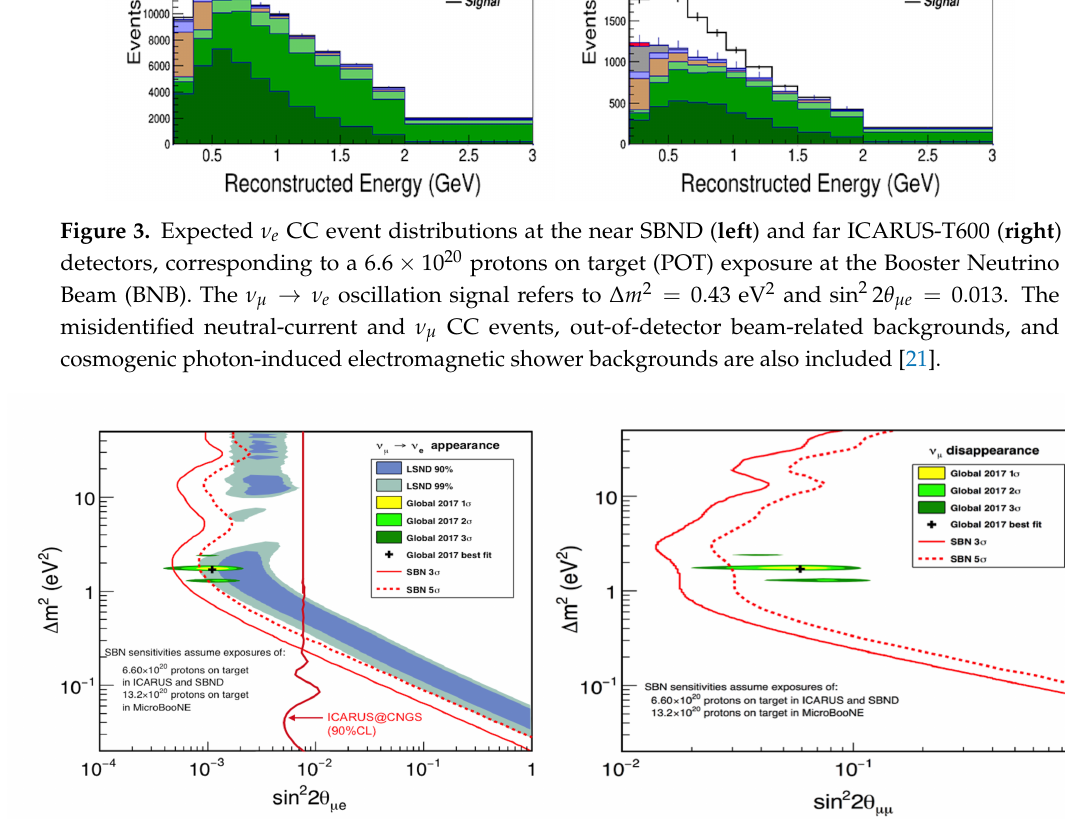
Figure 4. The expected sensitivity to ν µ → ν e ( left ) and the corresponding expected sensitivity to ν µ disappearance ( right ) provided by the SBN program, compared to the LSND positive result and to a global best fit expectation of all present neutrino anomalies [22]. A total exposure of 6.6 × 10 20 POT at the BNB beam for the SBND and ICARUS detector and 1.32 × 10 21 POT for the MicroBooNE detector have been considered